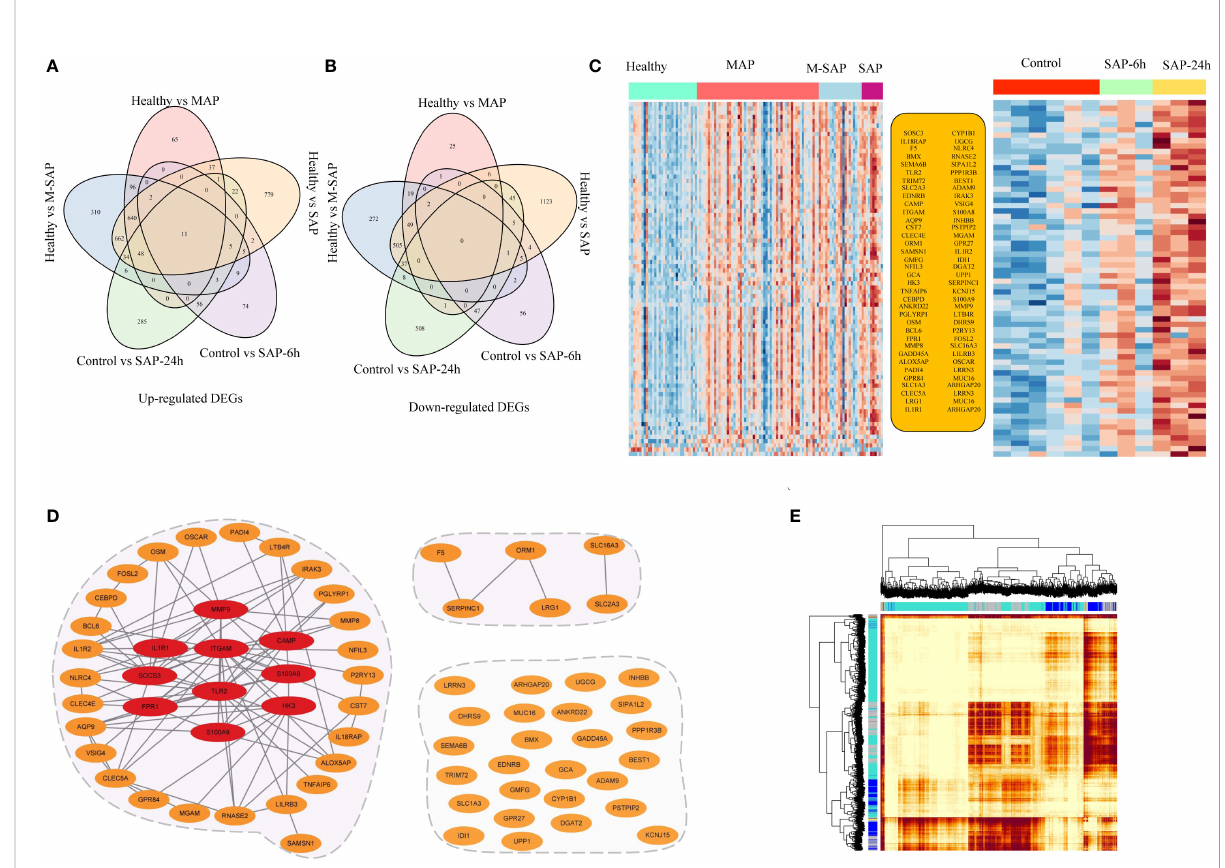
FIGURE 3 Speci fi c transcriptional characteristics and potential interaction mechanisms of AP-associated genes. (A, B) The Venn diagram represents the overlapping genes from human blood samples and the animal AP model. (C) Expression of 71 shared transcriptomes according to DEG analysis of human blood samples and samples from the animal AP model. (D) Interaction network analysis was applied using the STRING database and WGCNA. Orange dots represent the 71 AP-related genes. The red ellipse denotes the 10 hub genes that were scored with the cytoHubba tool. The gray edge represents the interaction relationships annotated by the STRING database. (E) Topological overlap matrix plots for AP